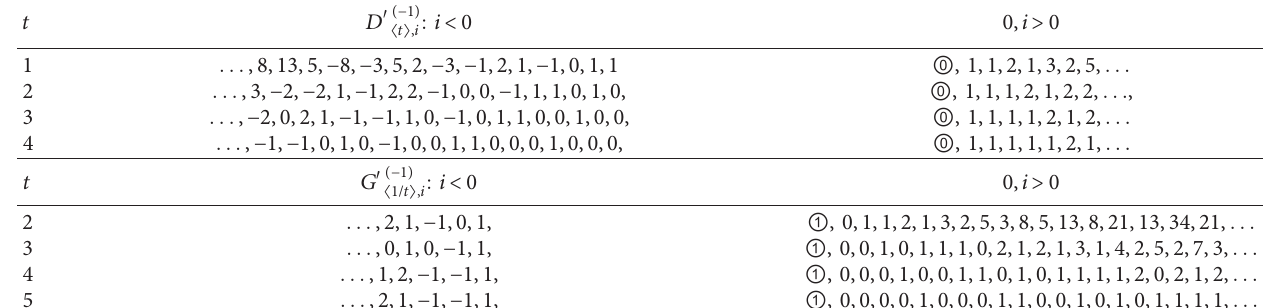
| i ∈ Z 􏽮 􏽯 , ( 1 ≤ t ≤ 5 ) 〈 1/ t 〉 ,i